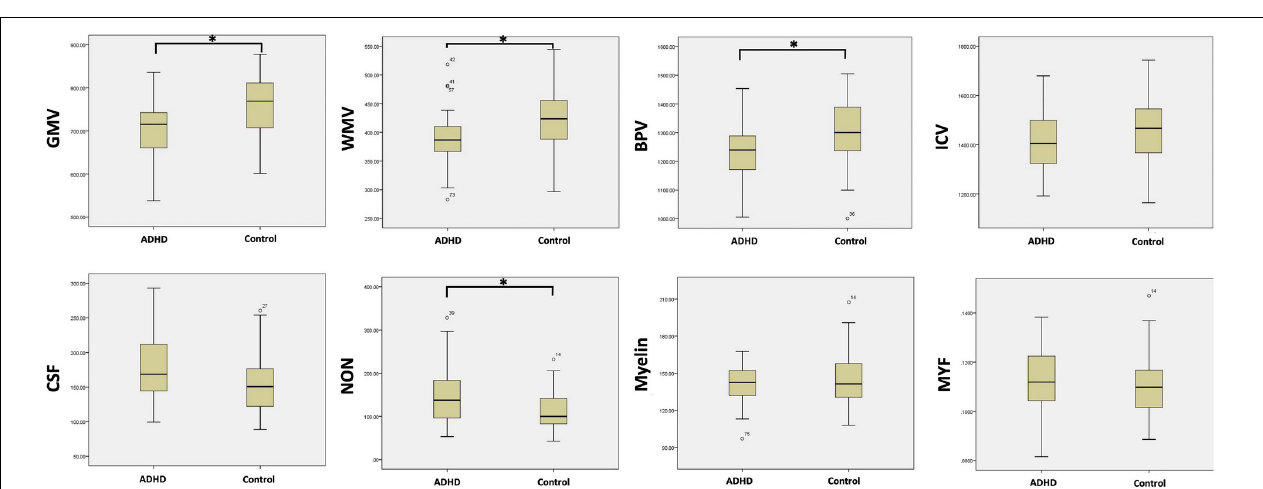
ratio in each voxel based on a predefined lookup grid to relate the tissue types to the R1-R2-PD space (West et al., 2012). Second, the SyMRI divides the brain tissue not only into gray